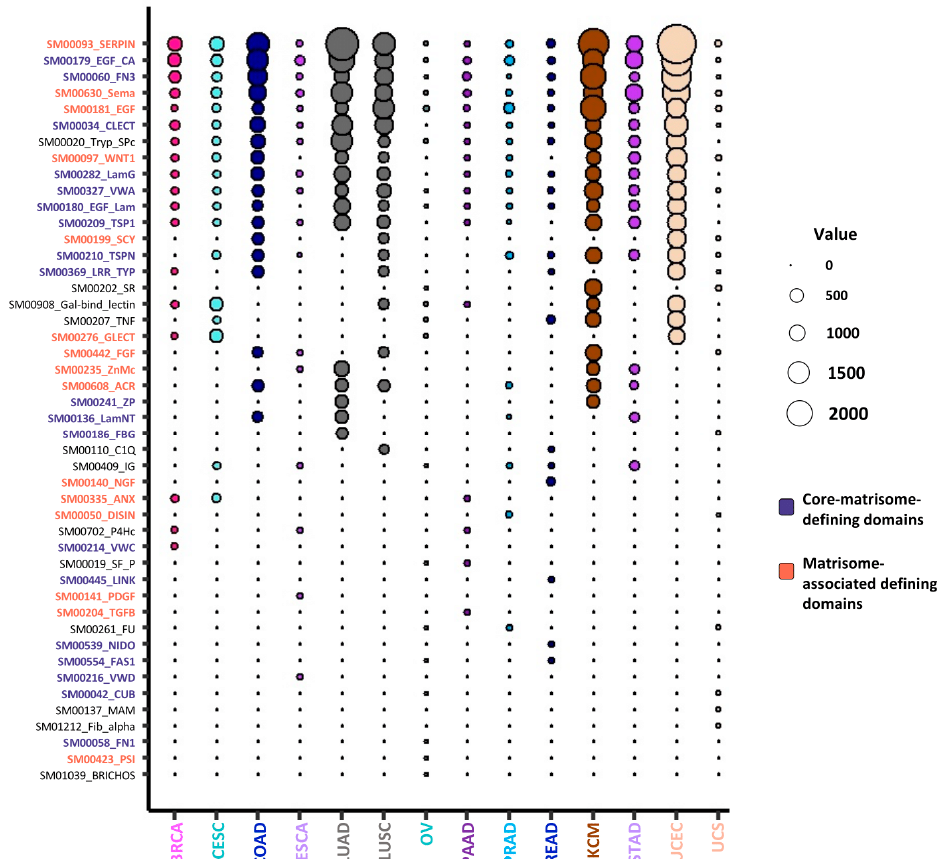
Figure 4. Top 20 most frequently mutated domains in extracellular matrix (ECM) proteins. Bubble plot represents the top 20 most frequently mutated domains in ECM proteins across all 14 cancer types analyzed. The color code indicates domains originally used to predict core-matrisome-proteins (purple) and matrisome-associated (coral) proteins (see [17] for details on matrisome-defining domains). The diameter of the bubbles is proportional to the mutation frequency of each domain in each cancer type. See also Table S3.